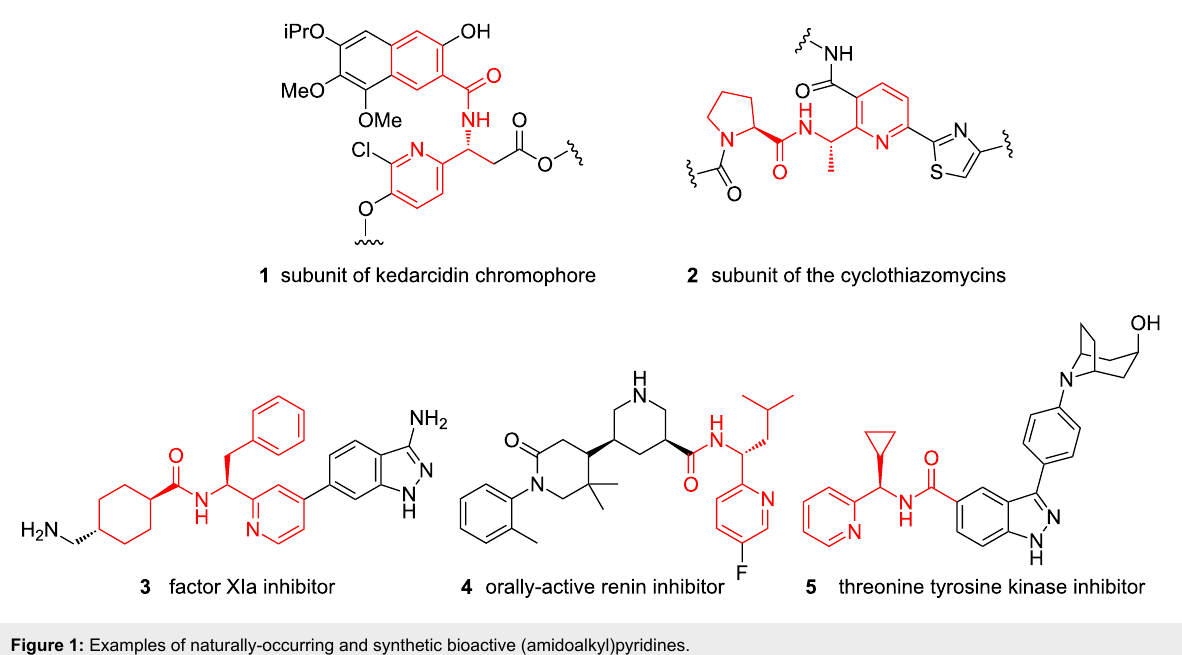
Figure 1: Examples of naturally-occurring and synthetic bioactive (amidoalkyl)pyridines.